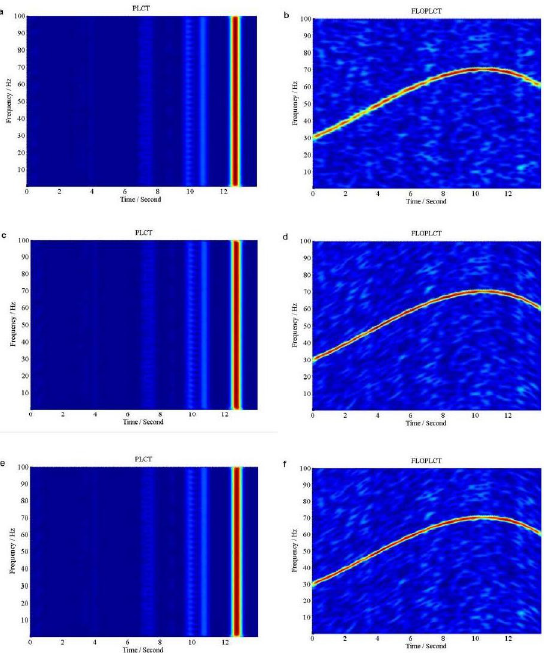
Fig 7. Time-frequency representations of the signal x ( τ ) in α stable distribution noise environment ( MSNR = 16 dB , α = 0.8). (a. The first time PLCT time-frequency representation of the signal x ( τ ); b. The first time FLOPLCT time-frequency representation of the signal x ( τ ); c. The second time PLCT time-frequency representation of the signal x ( τ ); d. The second time FLOPLCT time-frequency representation of the signal x ( τ ); e. The third time PLCT time-frequency representation of the signal x ( τ ); f. The third time FLOPLCT time-frequency representation of the signal x ( τ )).